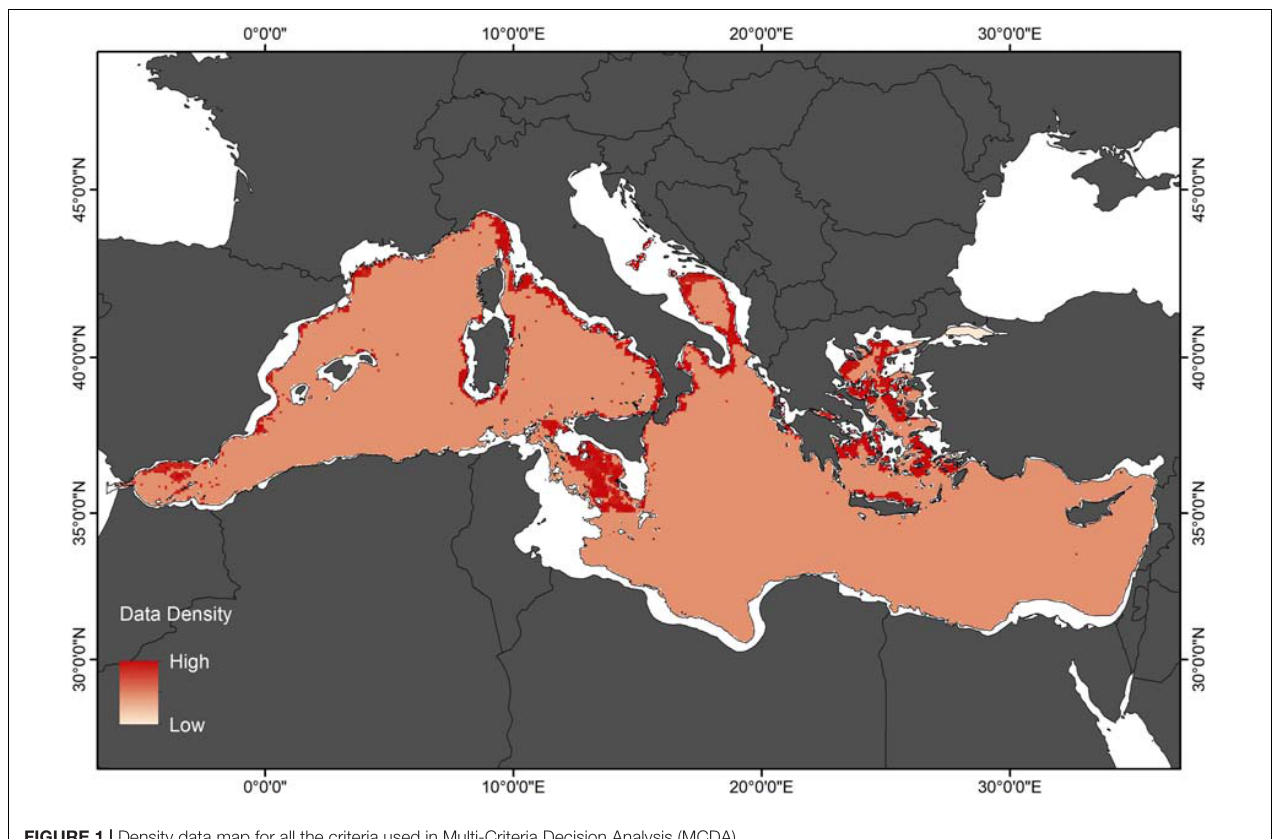
FIGURE 1 | Density data map for all the criteria used in Multi-Criteria Decision Analysis (MCDA).